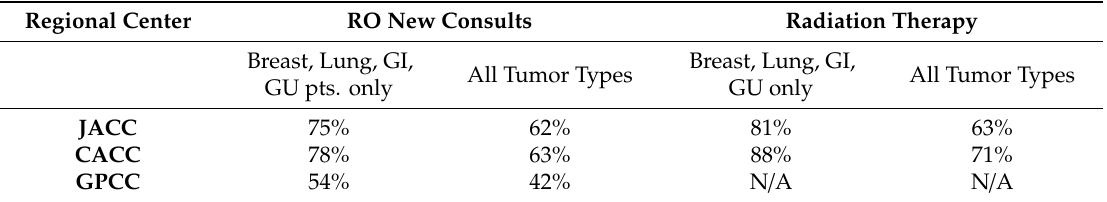
Table 1. New consults and treatments for radiotherapy according to CCTH (consultation and treat close to home) in 2017.